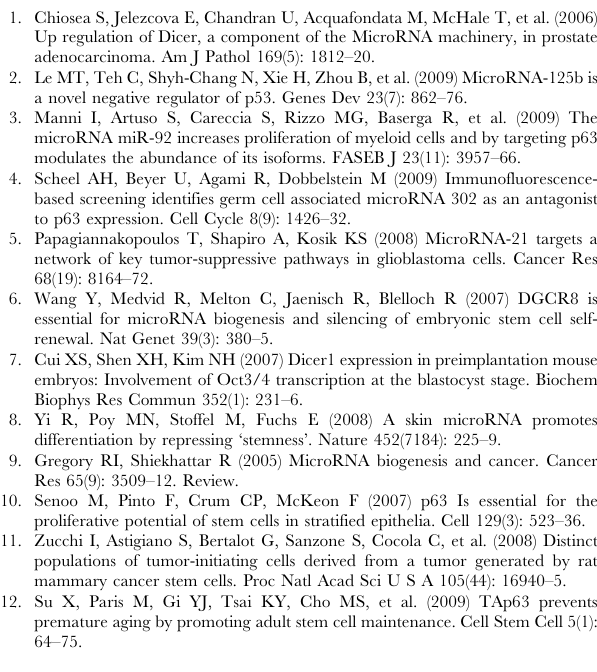
Table S2 p53/p63/p63-miRs that target components of the miRNA biosynthesis pathway.